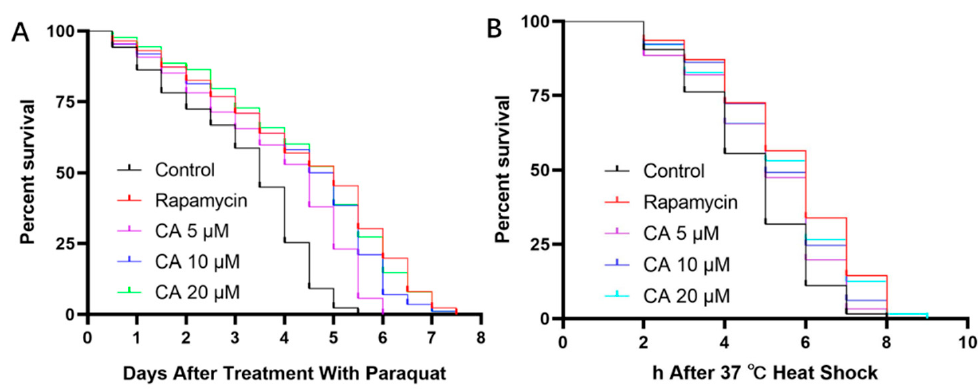
Figure 3. Effect of CA on C. elegans lifespan under stress conditions. Wild-type worms, after being synchronized to the L4 stage, were pretreated with DMSO (control) or with rapamycin (2 nM) or CA (5, 10, 20 µ M) for 5 days, followed by exposure to 5 mM paraquat ( A ) n = 86–90, p < 0.05) or 37 ◦ C heat shock ( B ) n = 62–66, p < 0.05). Table 3. Effect of CA on the mean lifespan of C. elegans in the presence of oxidative stress. Number of